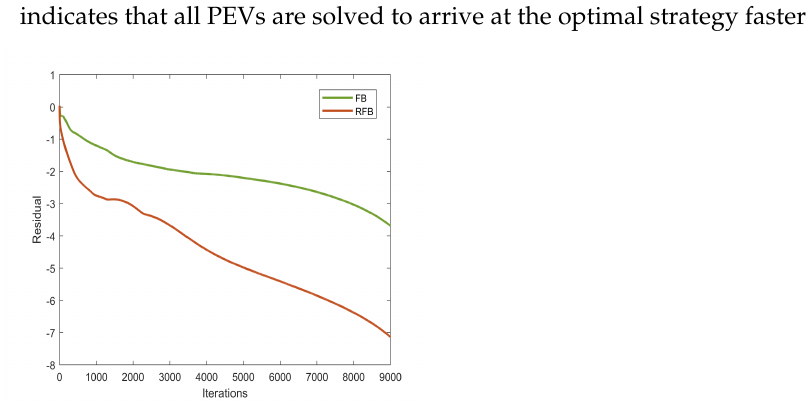
Figure 14. Convergence